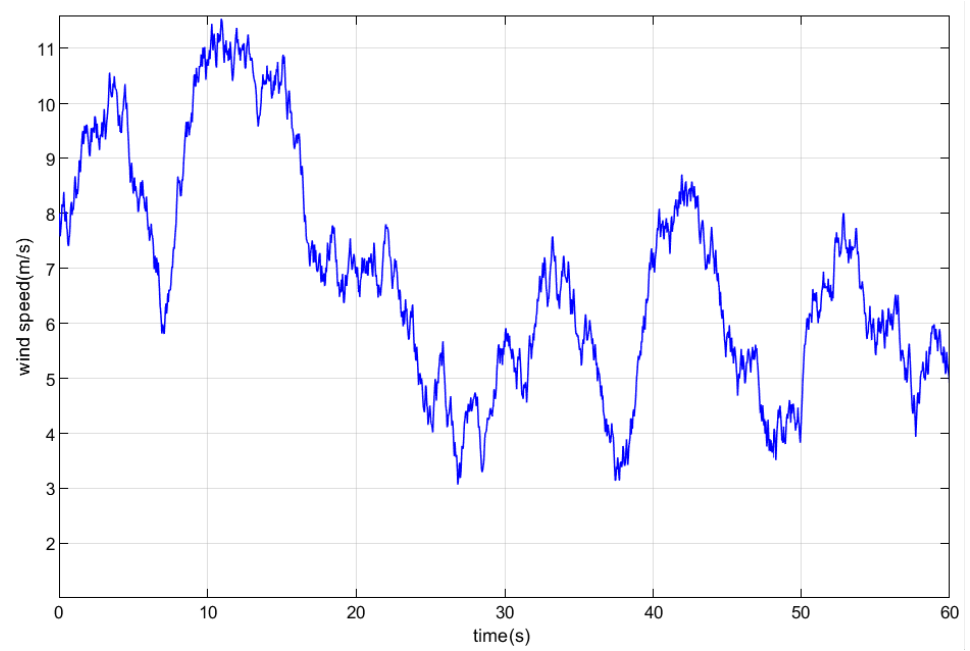
Figure 12. Wind speed